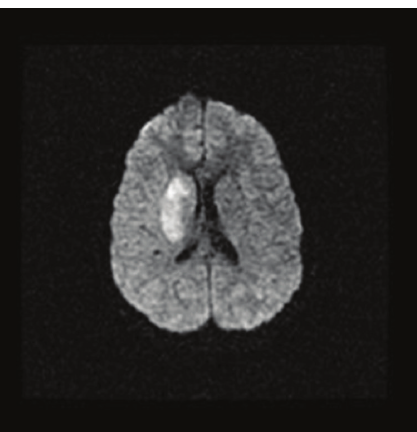
Figure 2: Coronal view of angiography arrow pointing to the area the Middle Cerebral Artery occlusion.